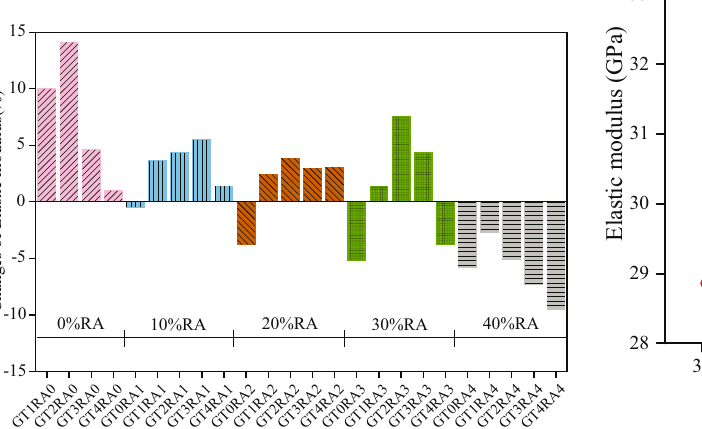
Figure 13: Relationship between compressive strength and modulus of elasticity of